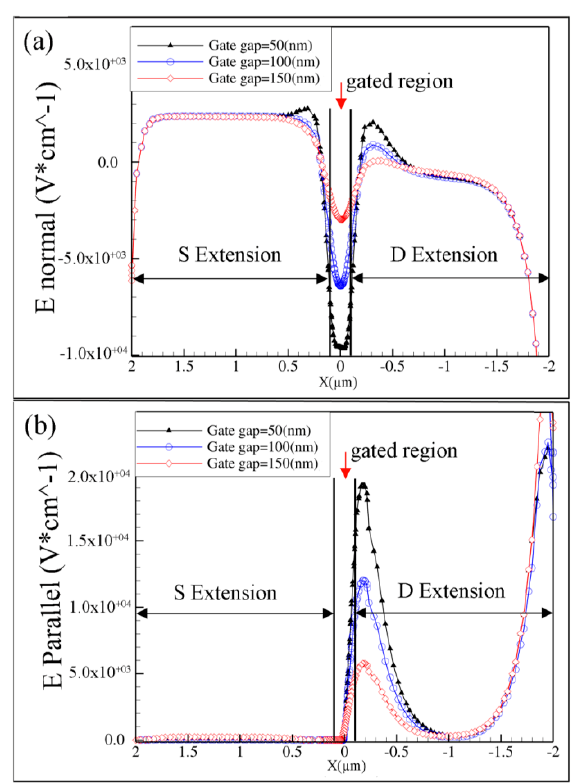
Figure 11. The electric field affected on the majority carriers along a horizontal cut line at Z = 50 nm in direction ( a ) perpendicular and ( b ) parallel to the channel.